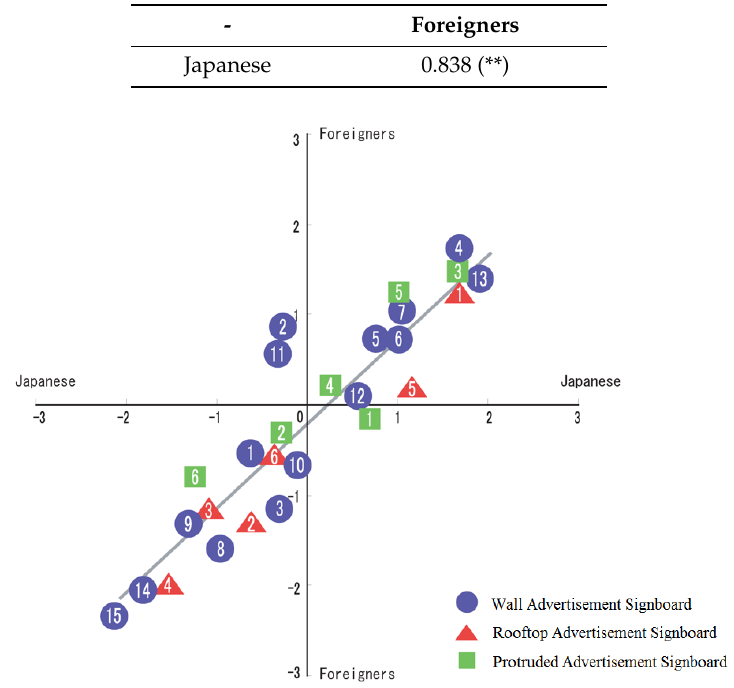
Figure 6. Scatter diagram of the correlations between Japanese and foreign nationals associated with oppressive feelings.